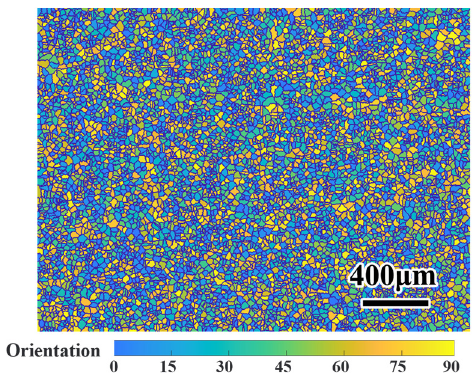
Figure 5. Initial grain structure generated for the CA simulations.